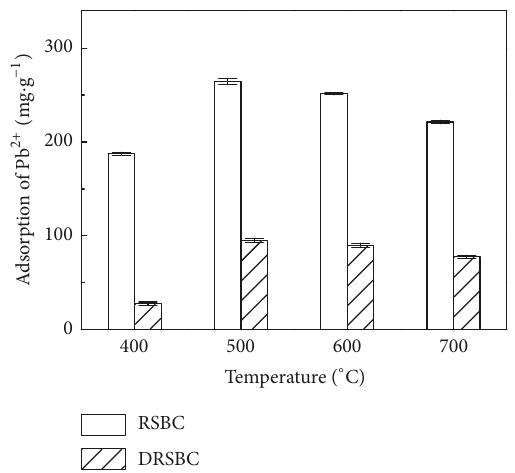
Figure 3: Pb(II) adsorption of biochars obtained at different pyrolysis